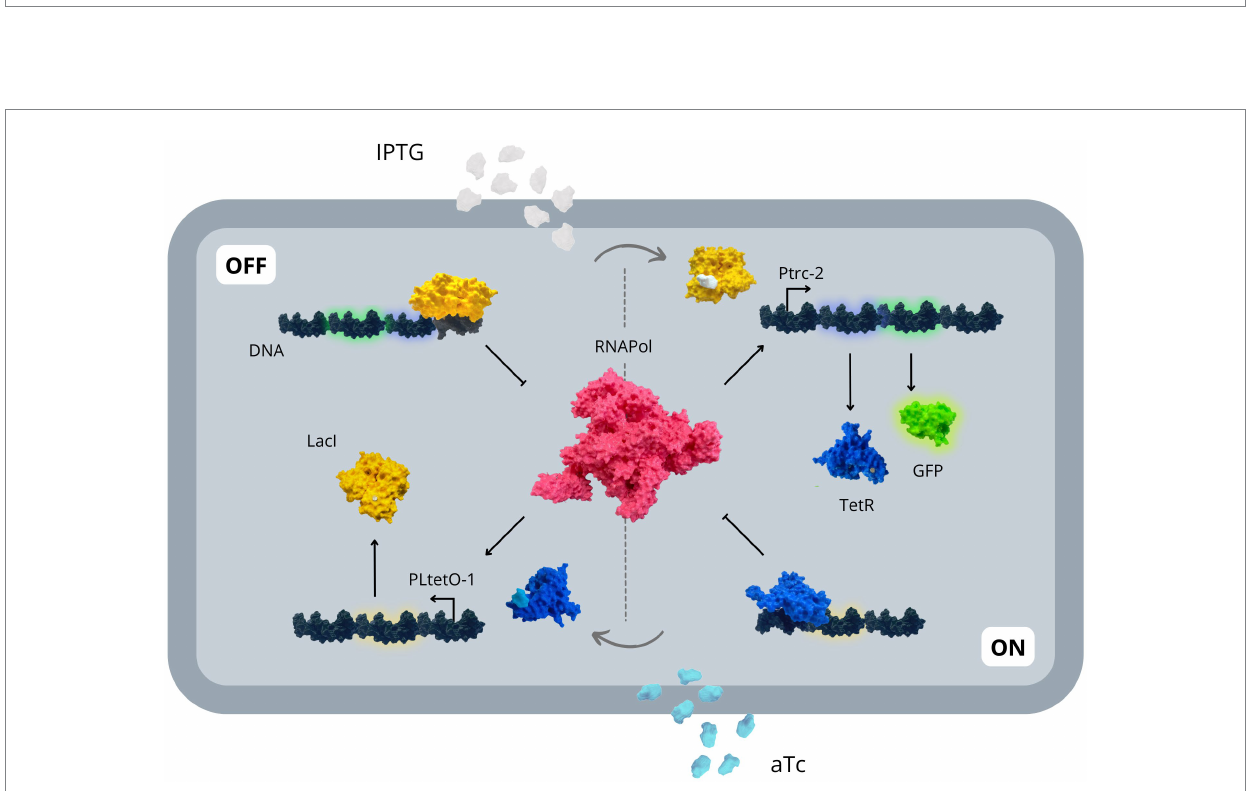
FIGURE 4 Different cellular states that compose the toggle genetic circuit in 3D printed molecules. The molecules and the genetic parts needed in the synthetic genetic circuit to turn it on its ON state are: IPTG (the inducer), LacI (repressor protein), and pTrc-2 (promoter). In its initial state, the LacI repressor is bound to the pTrc-2 promoter, blocking the RNA polymerase flow. After adding IPTG to the medium, it diffuses into the cellular environment, binds the LacI protein, releasing it from the pTrc-2 promoter, and allowing the function of the transcriptor. The cell is now in its ON state, expressing GFP and TetR. The TetR repressor protein binds to the P L tetO-1 promoter and blocks the RNA polymerase flow along the cassette. Then, now, to switch to the OFF state the molecules and the genetic parts needed will be aTc (inducer), TetR (repressor protein), and P L tetO-1 (promoter). Once the aTc is added to the medium, it diffuses into the cellular environment, binds the TetR protein, releasing it from the P L tetO-1 promoter, and allowing the function of the transcriptor. The cell is now in its OFF state, expressing LacI and thus repressing the first cassette from transcribing and traducing TetR and